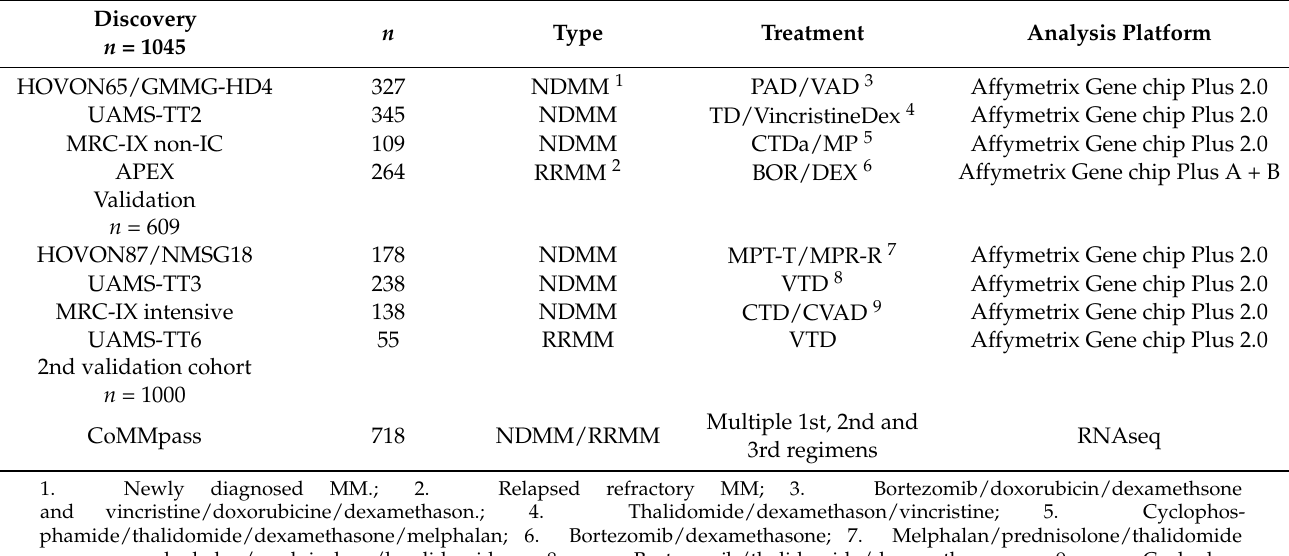
Table 1. Database covering 9 patient cohorts in MM listing number of patients, line of therapy, treatment arms and type of transcriptomic analysis performed.